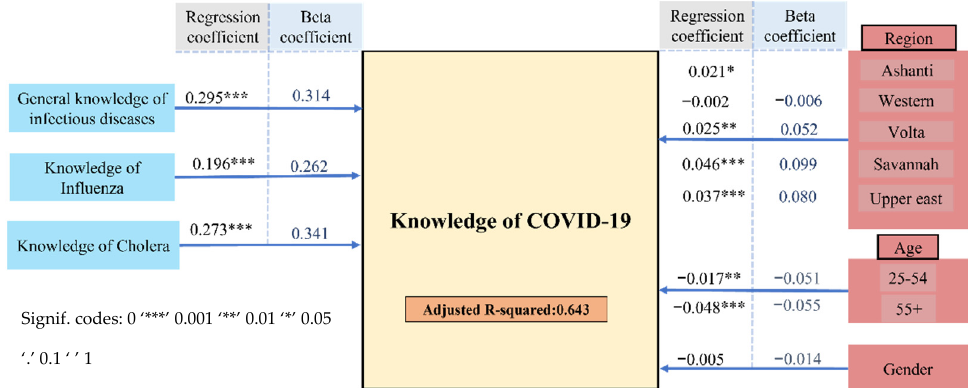
Figure 3. The knowledge of COVID-19 Model (KCM) which was employed to assess the influences of the other domains of knowledge surveyed on the knowledge related to COVID-19. The results are shown in terms of regression coefficient estimates (non-standardized coefficient) and beta coefficients (standardized coefficient).